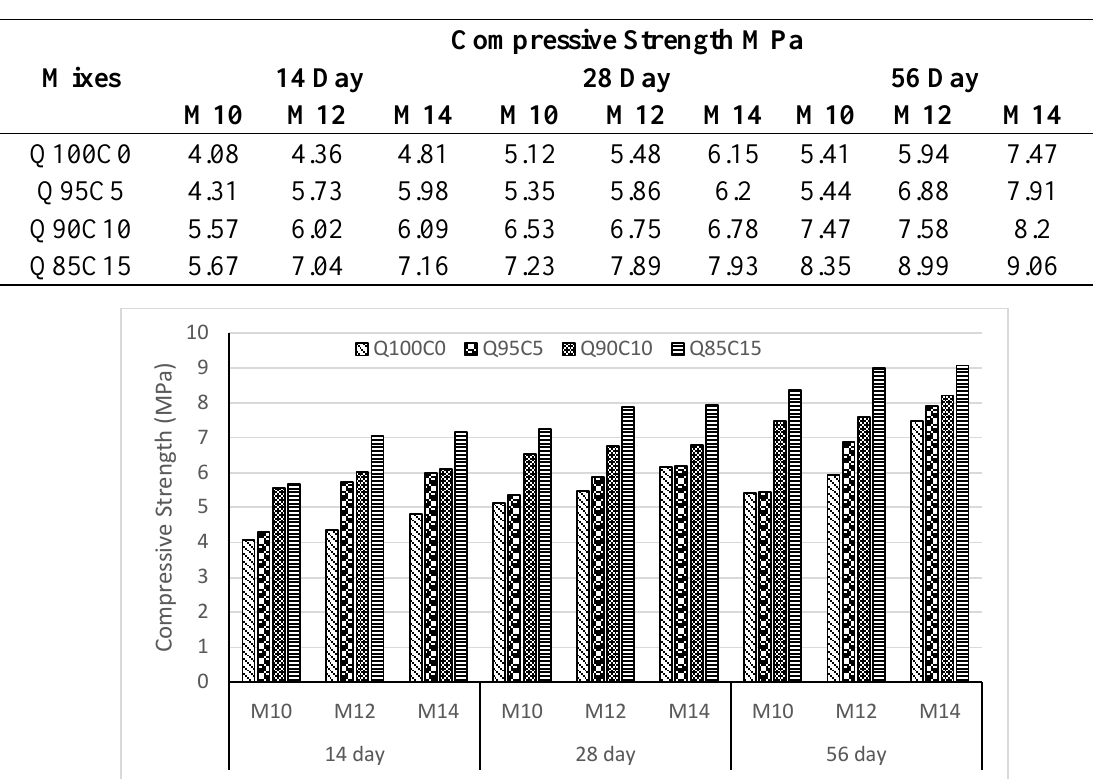
Table 4. Effect of OPC replacement and NaOH concentration variation on compressive strength.